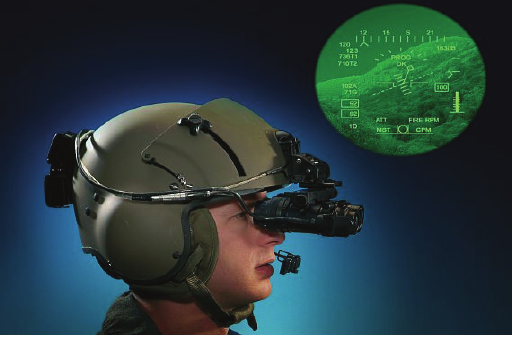
Figure 10 – ANVIS HUD with the head-up display Рис . 10 – ANVIS HUD с нашлемным целеуказателем Слика 10 – ANVIS HUD с a head-up